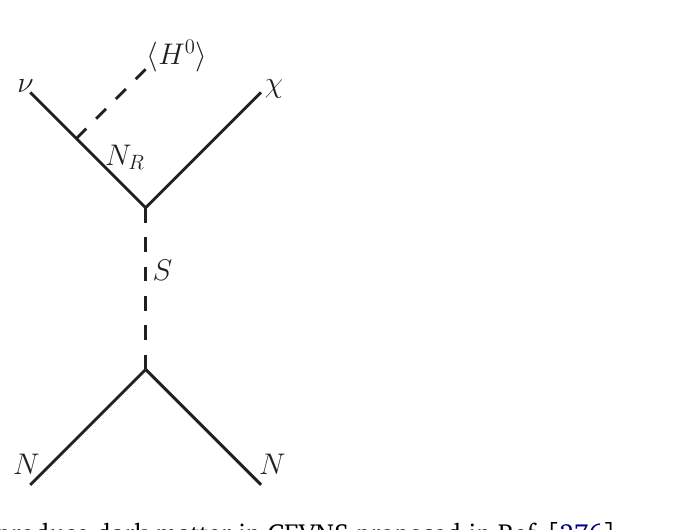
Figure 17.2: A process to produce dark matter in CEVNS proposed in Ref. [ 276 ]